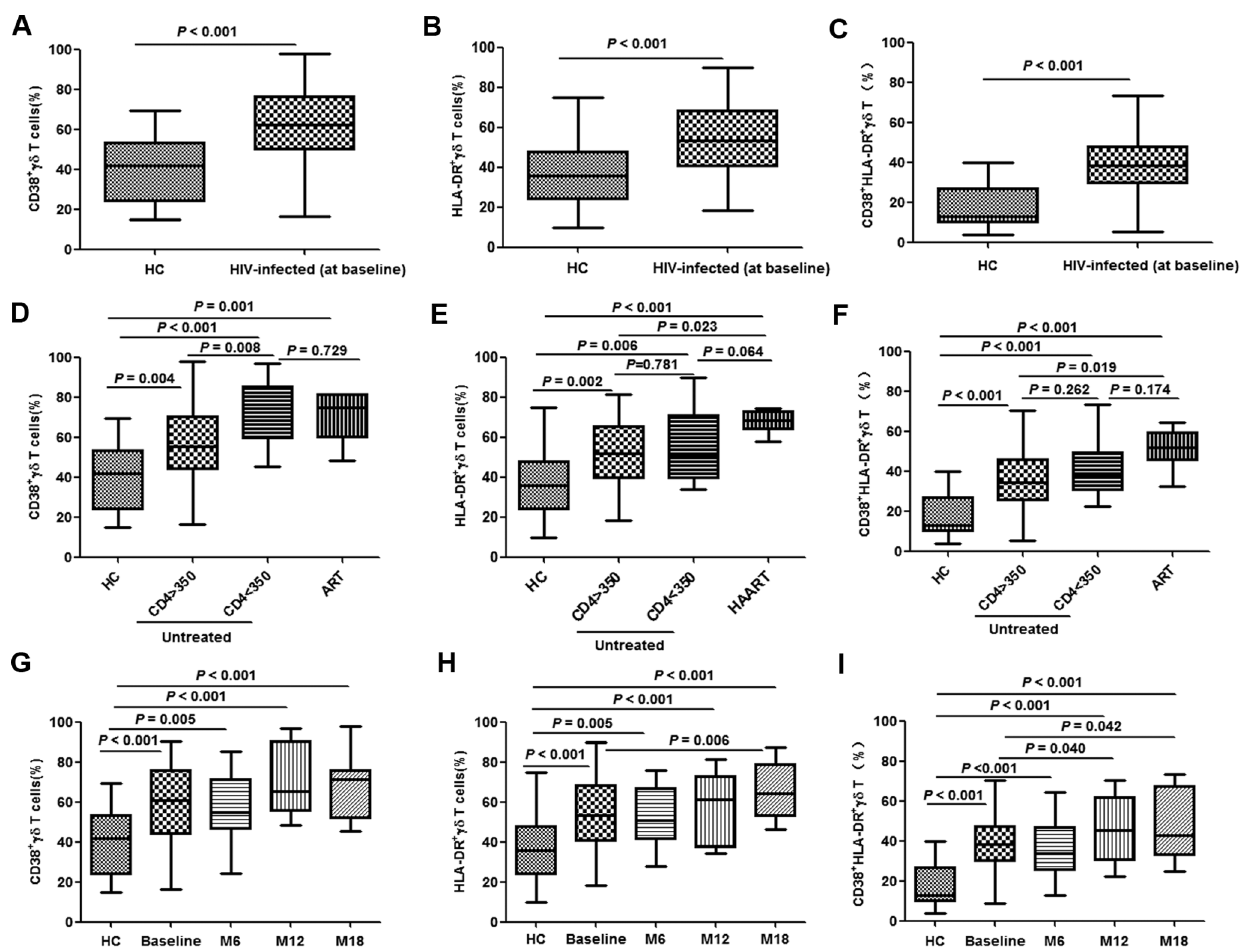
Figure 4. Activation of cd T cells in acute HIV infection. Activation of cd T cells was determined by analysis of CD38 and HLA-DR expression. Frequencies of CD38 + , HLA-DR + and CD38 + /HLA-DR + cd T cells were tested in healthy controls (HC) and acutely HIV-infected subjects at baseline ( A– C ). The patients were then subdivided based on the administration of antiretroviral therapy (ART) and CD4 levels ( , or . than 350/ m L). The frequencies were re-analyzed and compared with HC ( D–F ). Longitudinal follow-up of cd T cell activation in patients with acute HIV infection was conducted at baseline, month 6 (M6), month 12 (M12) and month 18 (M18). Frequencies of CD38 + , HLA-DR + and CD38 + /HLA-DR + cd T cells were tested in healthy controls (HC) and acutely HIV-infected subjects at baseline ( G–I